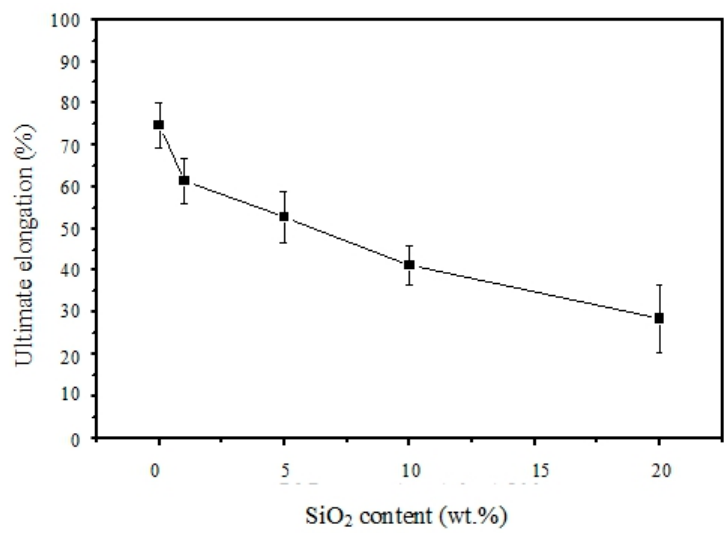
Figure 11. Elongation at-break results of the composite membrane samples at room temperature.